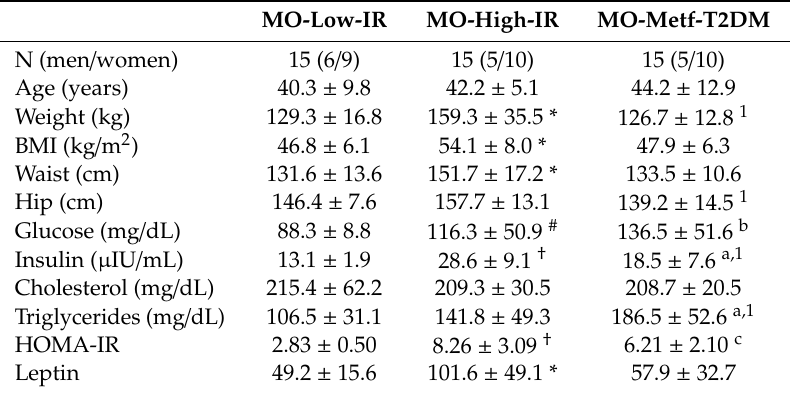
Table 1. Anthropometric and biochemical variables of the morbidly obese